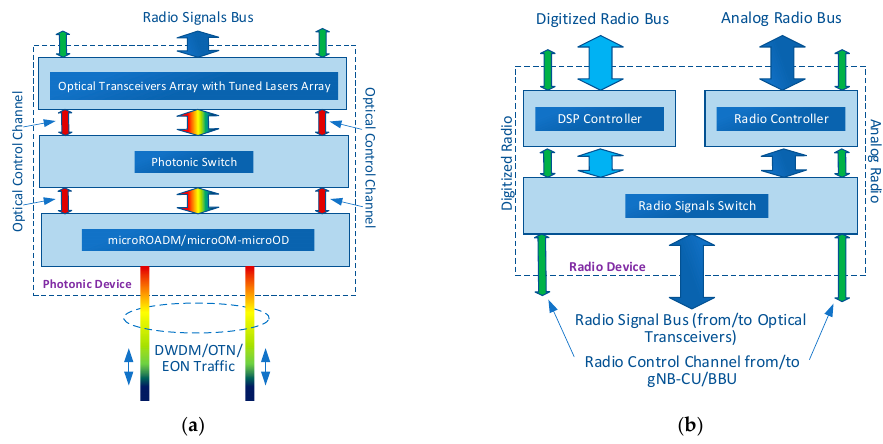
Figure 3. Switching and processing devices of integrated optical gNB-DU/RRH: ( a ) block construction of the photonic part with microROADM/microOM–microOD inside, ( b ) block construction of a common radio part with the digitized and analog radio signals switch (presented in proceedings [6]). Next block (Figure 3b) is connected to an electric bus that has a large number of transmission lines. The number of transmission lines depends on the number of media converters included in the radio-photonic block. The transmission bus provides signals to the ports of the signal switch, whose task is to direct the appropriate signal for initial preparation or separation, before entering them to the specific radio antenna subunit. The digital signals go to the DSP controller, which demultiplexes/ multiplexes streams in the time domain and organizes them so that they reach the appropriate transmission line connecting with a specific radio-antenna module. The analog signals go to the radio controller, where they are pre-prepared (e.g., adaptation to the transmission line, correction of time and frequency parameters, or pre-amplification in a small range). The analog radio signal (A-RoF format) can come from the following ranges: BB, IF, or RF.